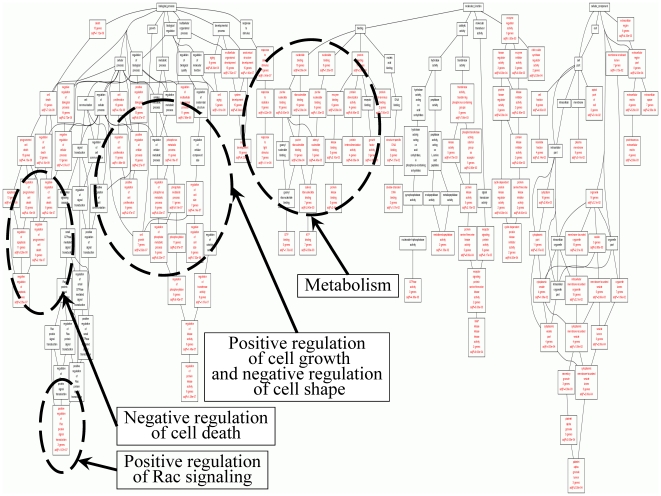
Further resolution of GO functions showed that the majority of genes (∼30%) are related to metabolism.However, despite the small size of the dataset that we used, it appeared that those selected genes participate significantly in a variety of cellular functions.